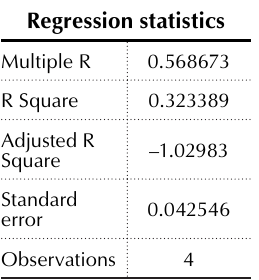
Table 6. Dynamics of the